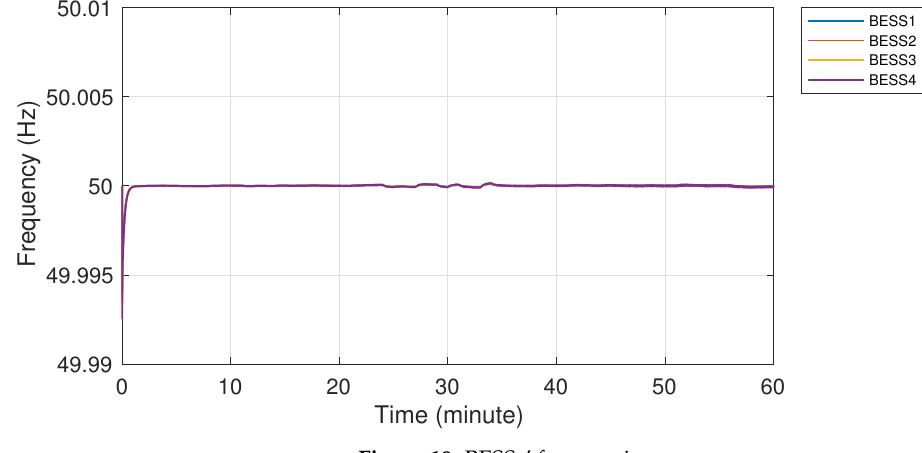
Figure 19. BESSs’ frequencies.